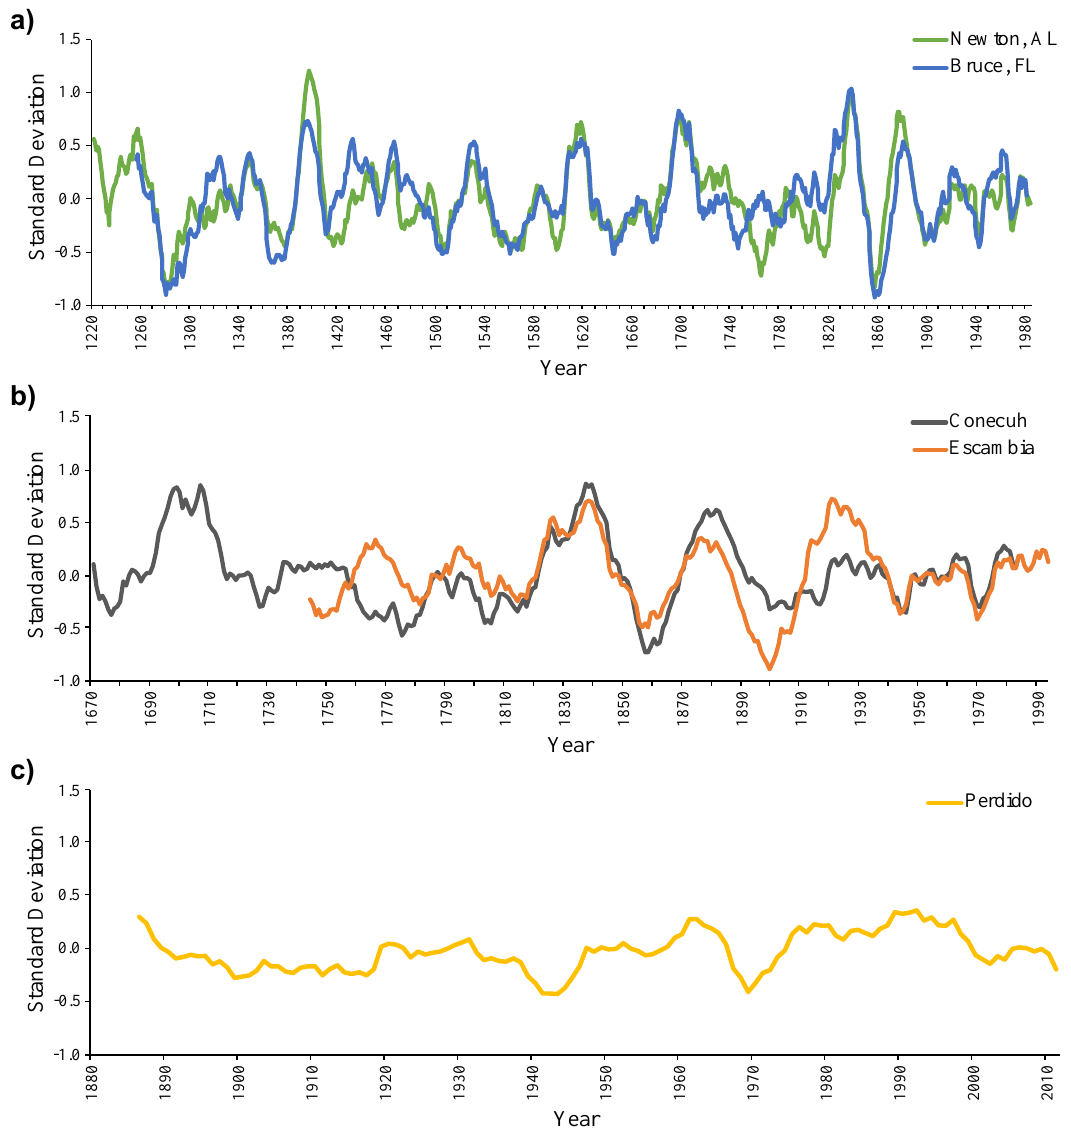
Figure 2. Standardized streamflow reconstructions for the ( a ) Choctawhatchee River at gages in Newton, AL (1222–1985) and Bruce, FL (1257–1982), ( b ) Conecuh River (1671–1983) and Escambia River (1744–1993), and ( c ) Perdido River (1885–2011). All datasets have been smoothed with a 20-year-end-year running mean. For full time scale see Figure A1. For comparison, the Pascagoula river gage near Merrill, MS is presented relative to the three other streamflow reconstructions for the AL-FL rivers (Figure 3). Unlike the riv- ers along the AL-FL border, the Pascagoula River has demonstrated a recovery in stream- flow over the last 20–30 years (Figure 3), indicating a potential divide in the hydro-clima-